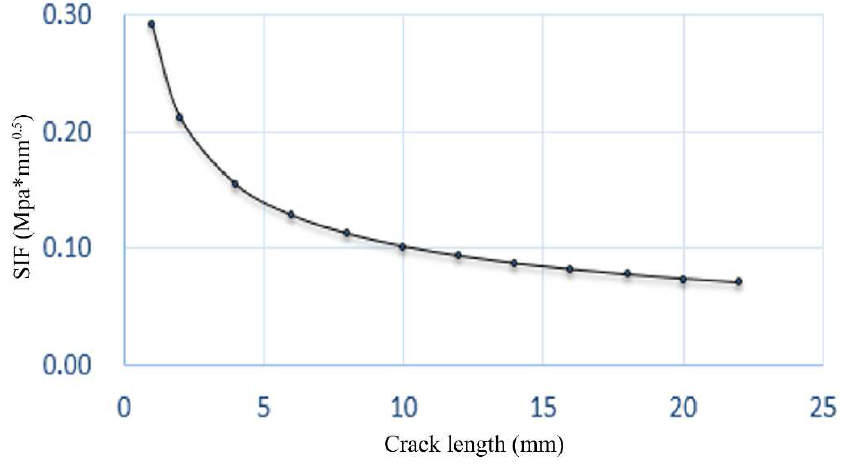
Figure 7. The variation in SIF with crack propagation.